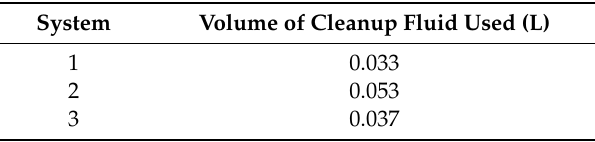
Table 3. Wettability inversion